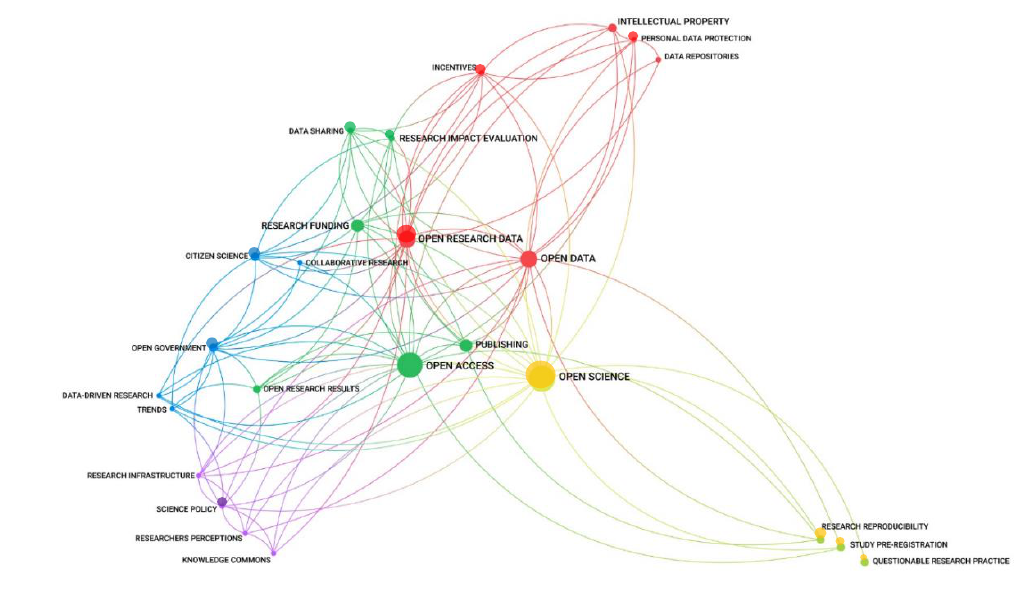
Fig. 2. Open Science concept map based on a keyword co-occurrence network analysis.